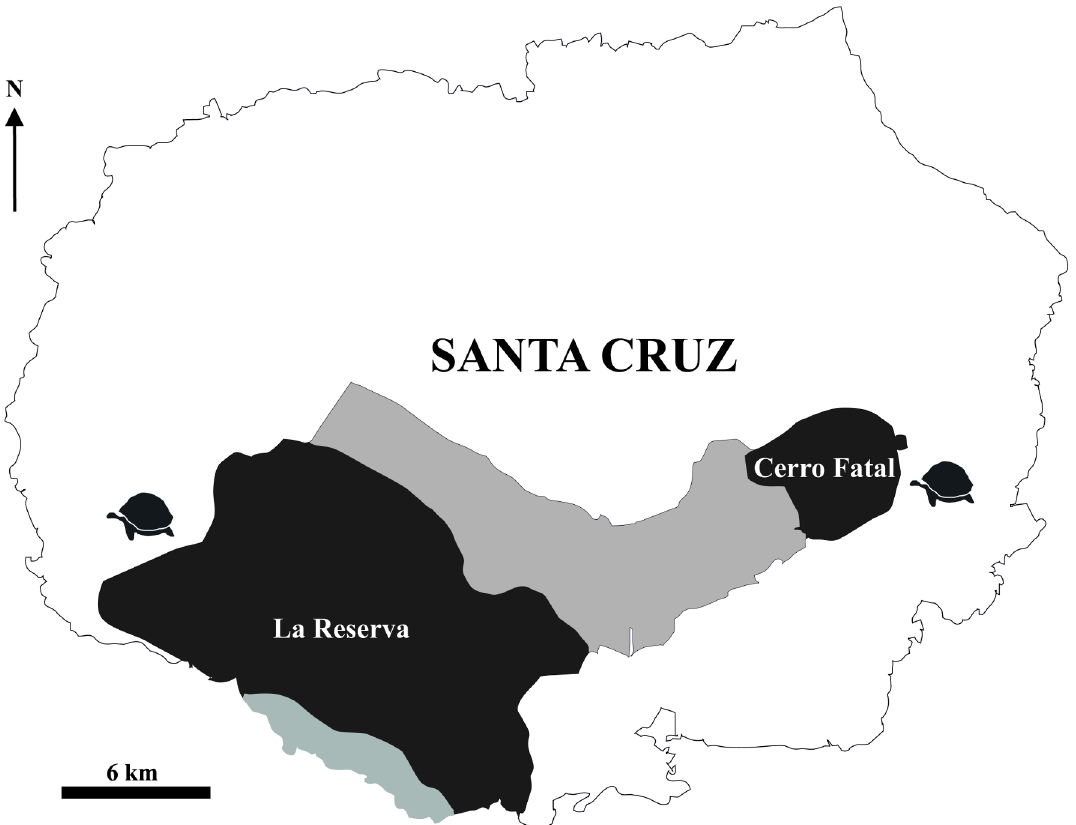
Fig 1. Geographic distribution of the two known lineages of giant tortoises on Santa Cruz Island: Chelonoidis porteri (Reserva) and Chelonoidis sp. nov. (Cerro Fatal) (indicated in dark gray). Light gray area connecting the distribution areas of the two species indicates agricultural land. Modified from Russello et al.